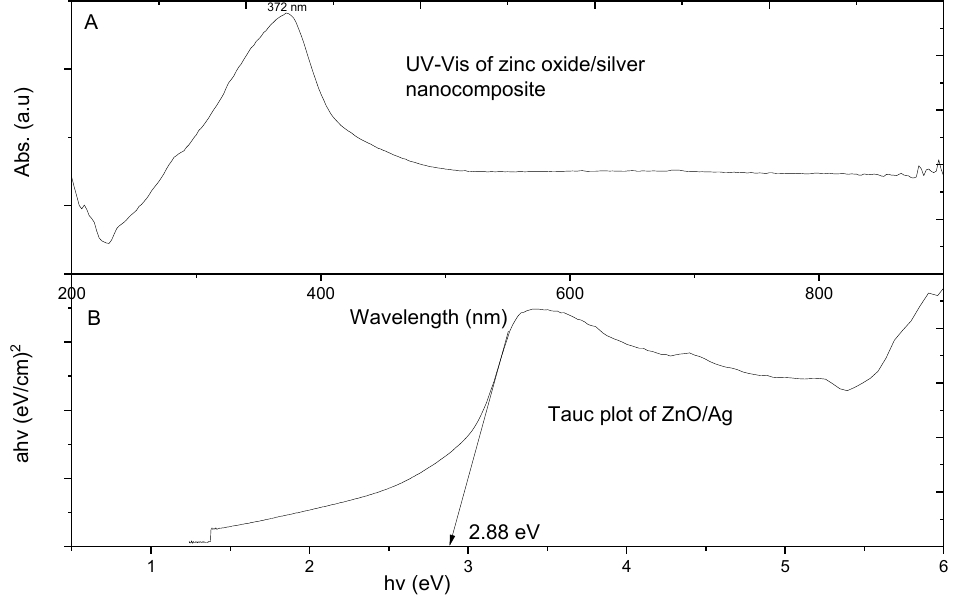
Figure 7. UV–Vis spectra of ZnO / Ag nanocomposite with its equivalent plot showing its energy band Figure 7. A UV–Vis spectra of ZnO/Ag nanocomposite with its equivalent plot showing its energy gap, adapted from reference [19]. ( A )-Ultraviolet–visible (UV–Vis) spectrophotometric absorption band gap, adapted from reference [19]. spectra of ZnO / Ag and ( B )-Tauc plot of ZnO /